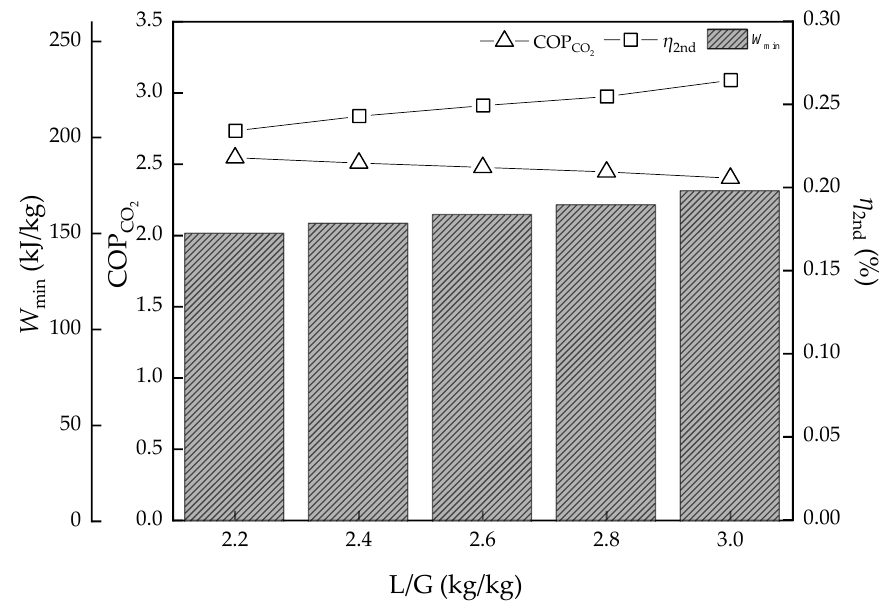
Figure 7. The energy efficiency performance with L/G value variation.